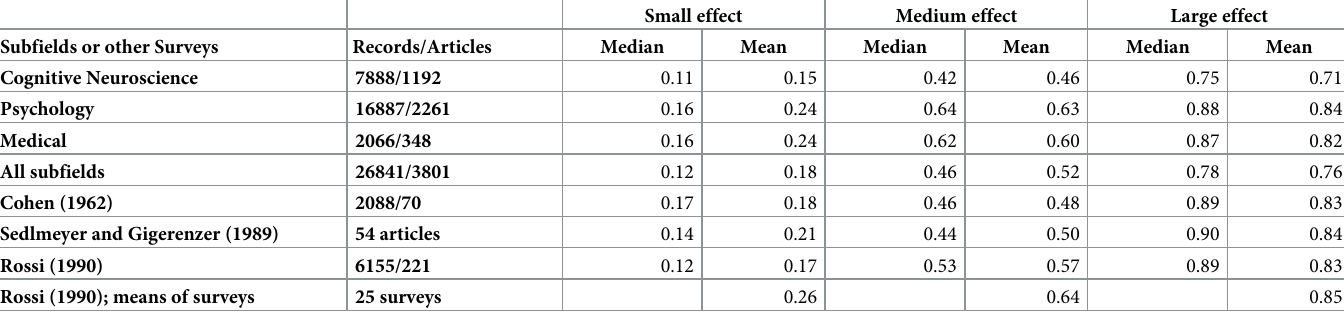
Table 1. Median and mean power to detect small, medium, and large effects in the current study and in three often-cited historical power surveys. The bottom row shows mean power computed from 25 power